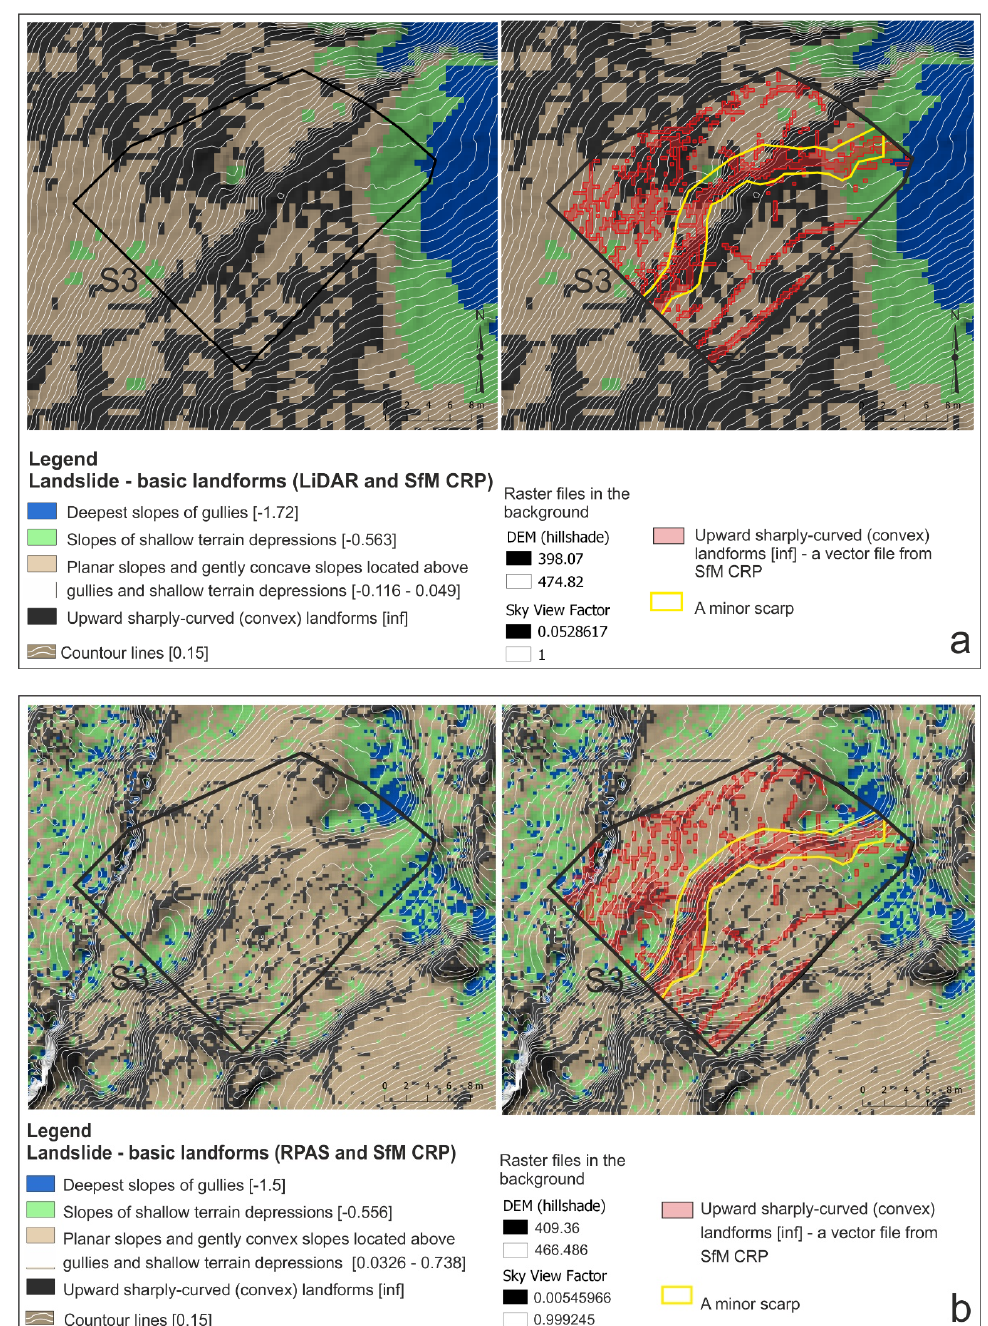
Figure 6. Minor scarp documented in raster files visualizing landslide landforms derived from data gathered by ( a ) LiDAR (Spring 2011) and SfM CRP (Spring 2017) in red, and ( b ) RPAS and SfM CRP (Spring 2017) in red.